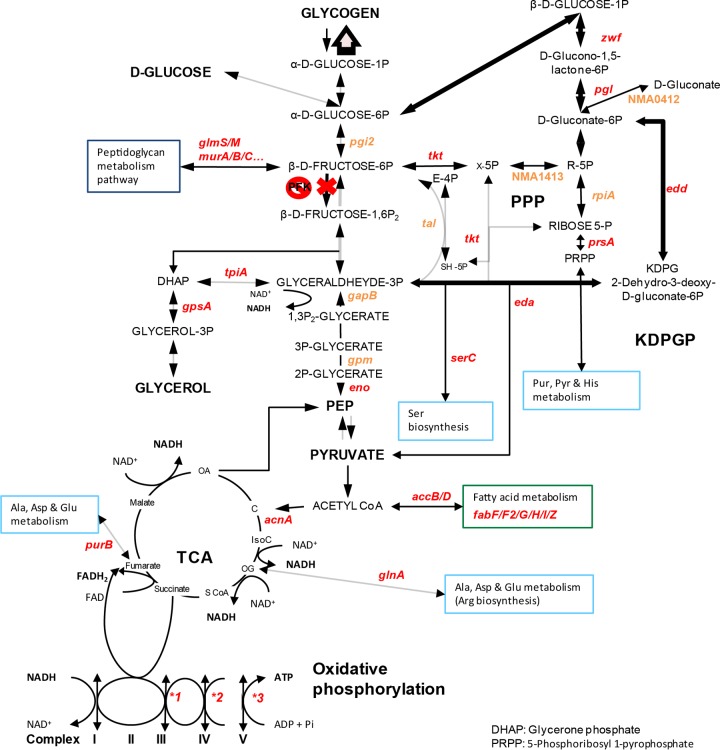
Schematic representation of the main metabolic pathways of essential genes for routine growth of N. meningitidis. The main essential genes for growth on GCB agar plates and CCM are highlighted in red, and the genes that encode proteins that cause a severe growth defect are highlighted in orange. *1, essential genes petA, -B, and -C; *2, essential genes ccoO and -N; *3, essential genes atpA, -B, -D, -F, and -G and growth-defective genes atpE and -H.